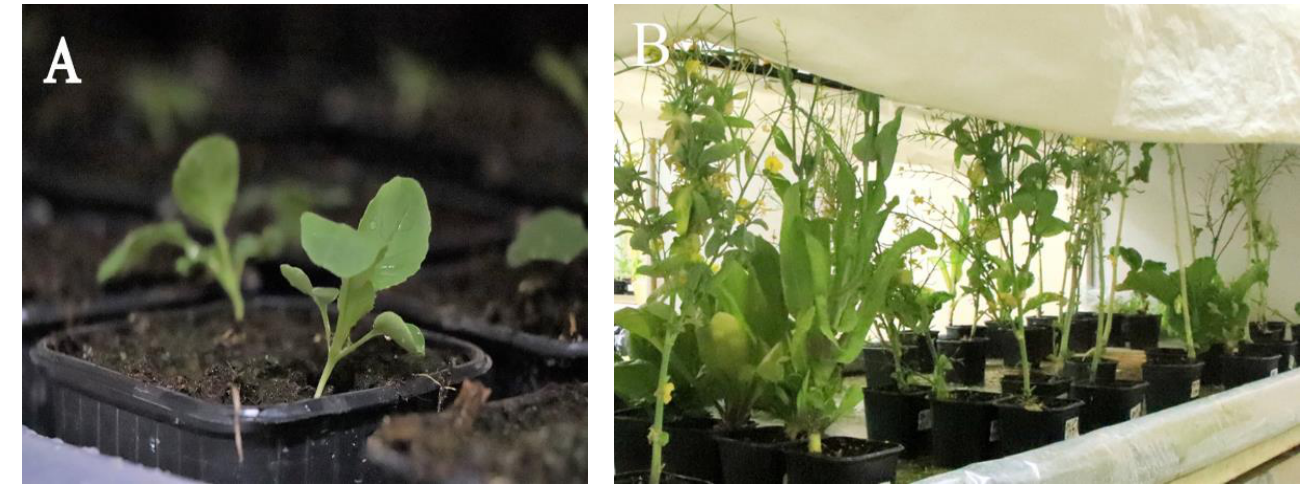
Figure 1. Plants of DH lines Brassica rapa L. grown under light culture conditions: ( A ) seedlings; ( B ) flowering.